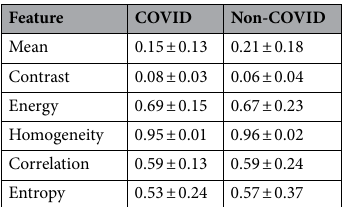
Table 1. GLCM Feature